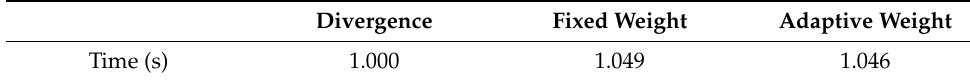
Table 6. Computational burden of the three algorithms in DS1.